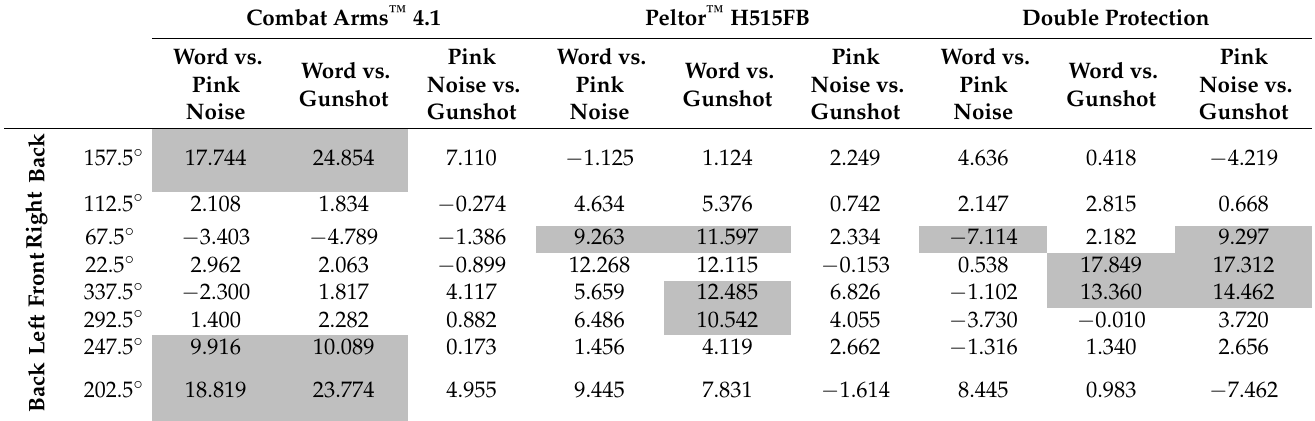
Table 4. Post hoc analysis (LSD) for comparison between stimuli using different HPDs and from different source angles. Combat Arms ™ 4.1 Peltor ™ H515FB Double Protection Word